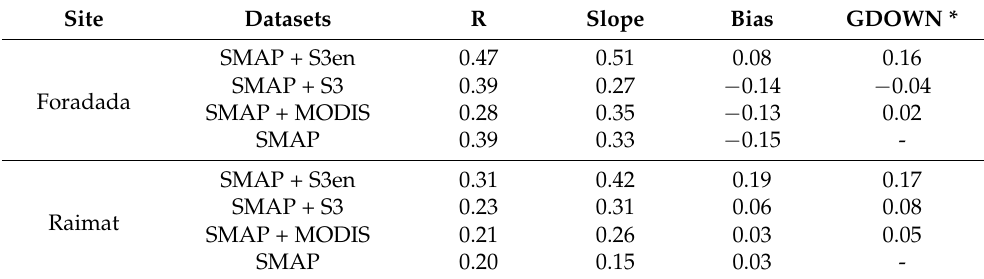
Table 2. Comparison of three different DisPATCh disaggregated SSM against in situ measurements. Site